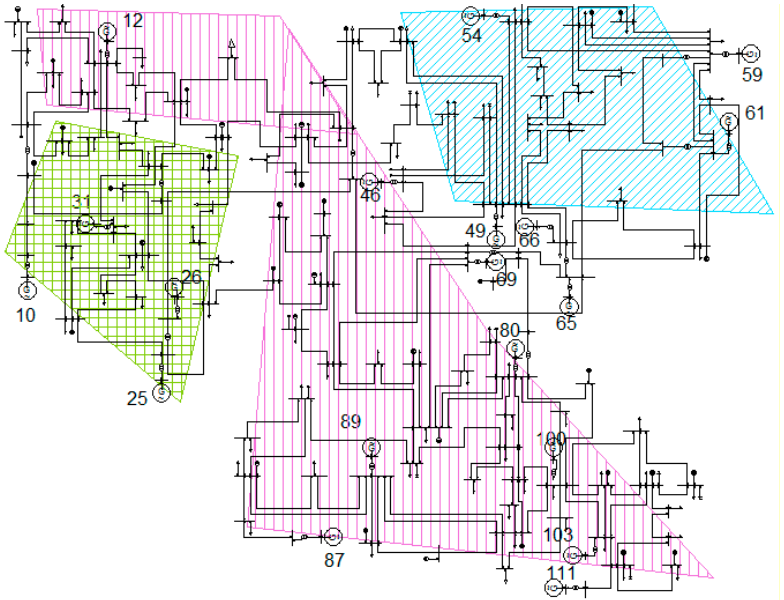
Table 3. Limits of fault events in the three zones.